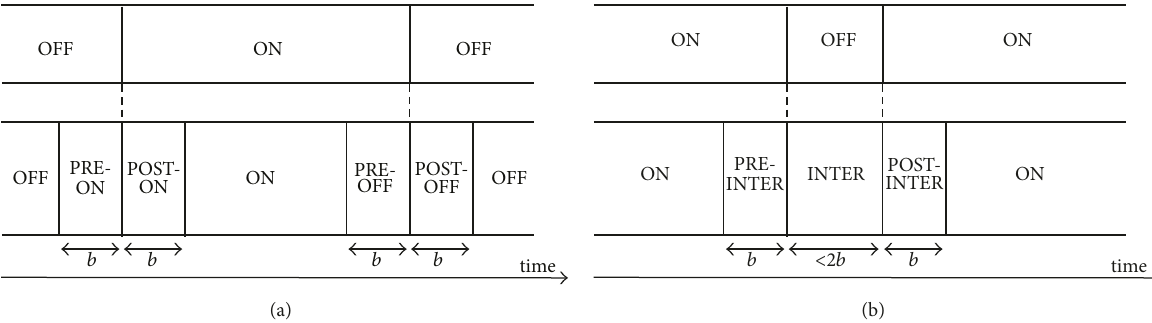
Figure 2: State classification. The loop benchmark states are converted to a ground truth classification. (a) denotes the buffering near normal ON/OFF switches; (b) shows what happens when the loop switches ON → OFF → ON in a short time